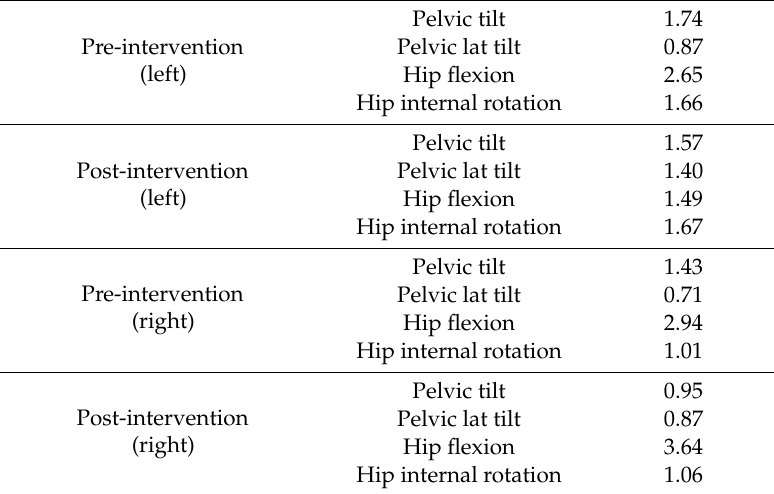
Table 2. Average root mean squared error (RMS error) between the three repeated trials during the seated hip flexion task for pre- and post-intervention.